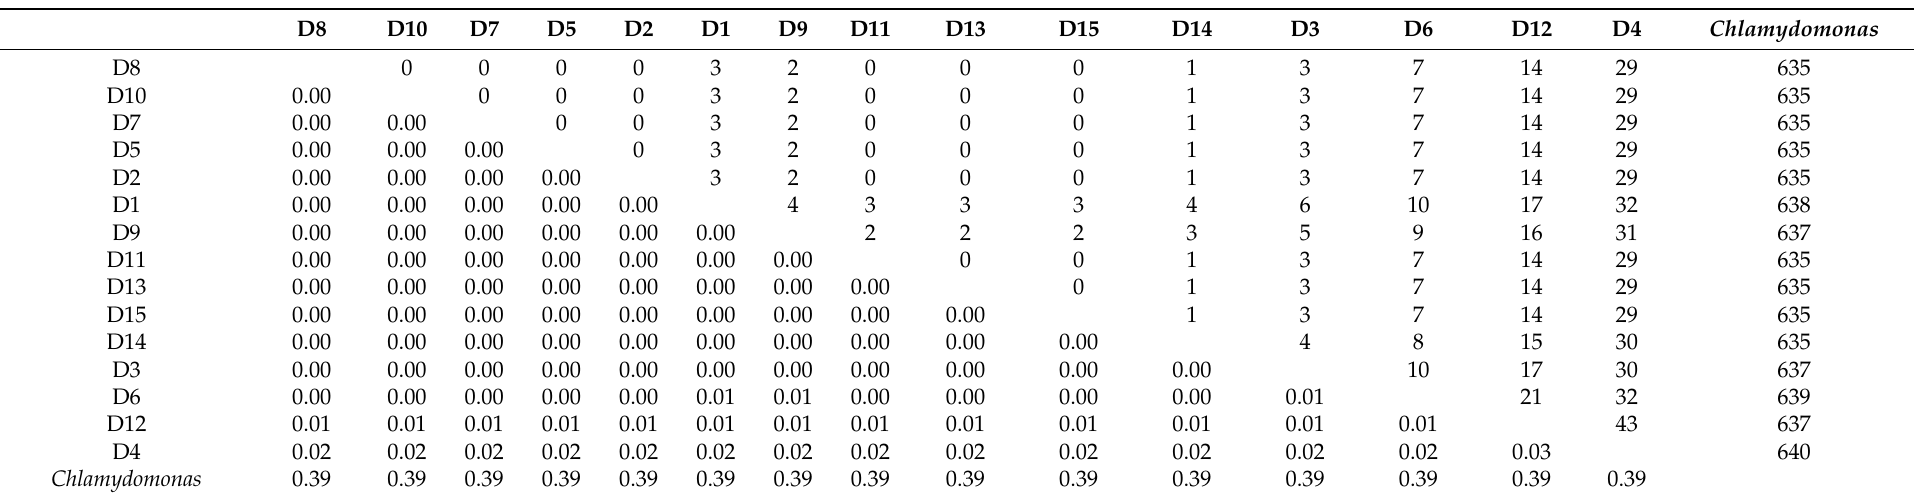
Table 5. GGPS genetic distance among 15 Dunaliella